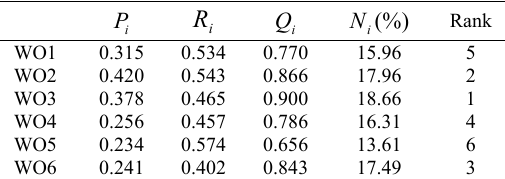
Table 9: Results of fuzzy COPRAS